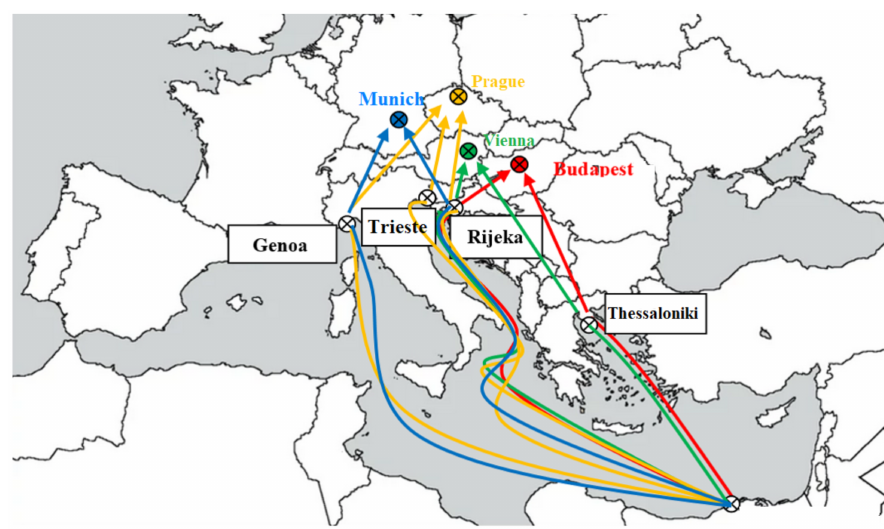
Figure 4. Selection of optimal tra ffi c routes, according to the set research model